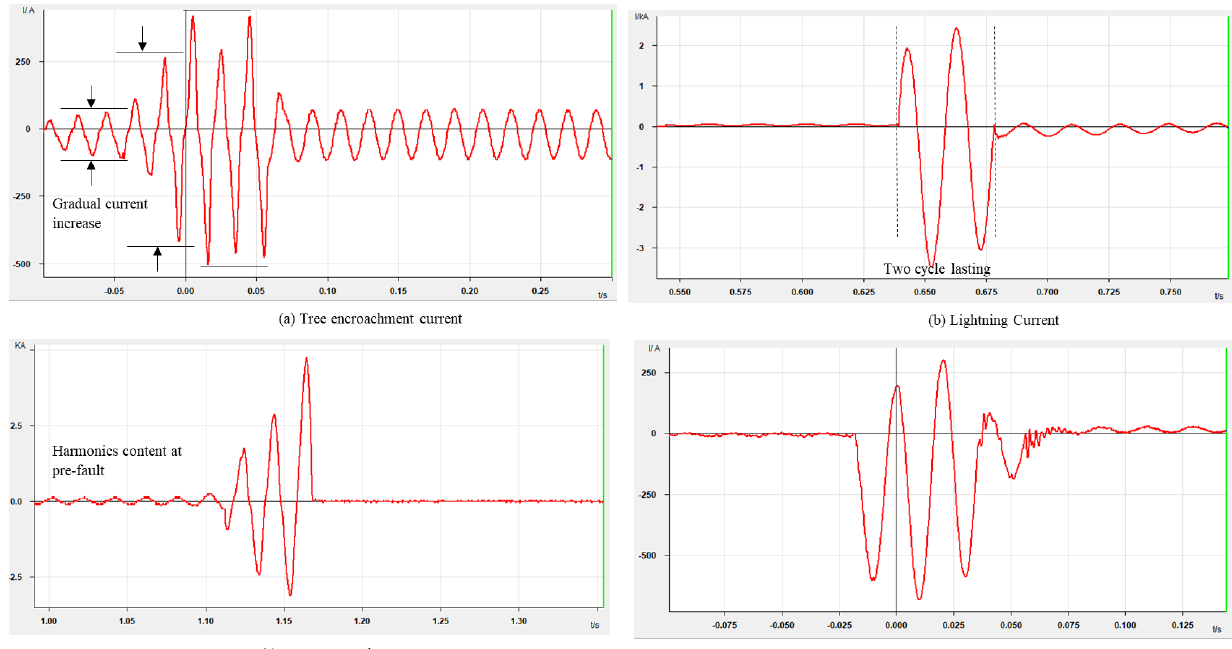
Figure 14. Fault signature of neutral current sinusoidal waveform.